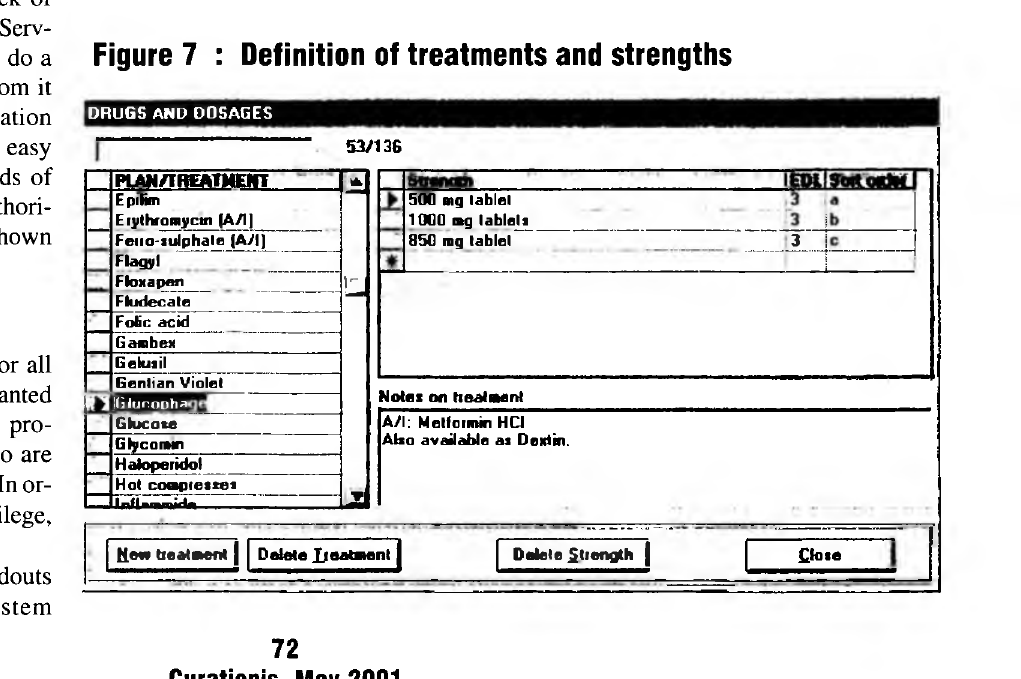
Figure 7 : Definition of treatments and